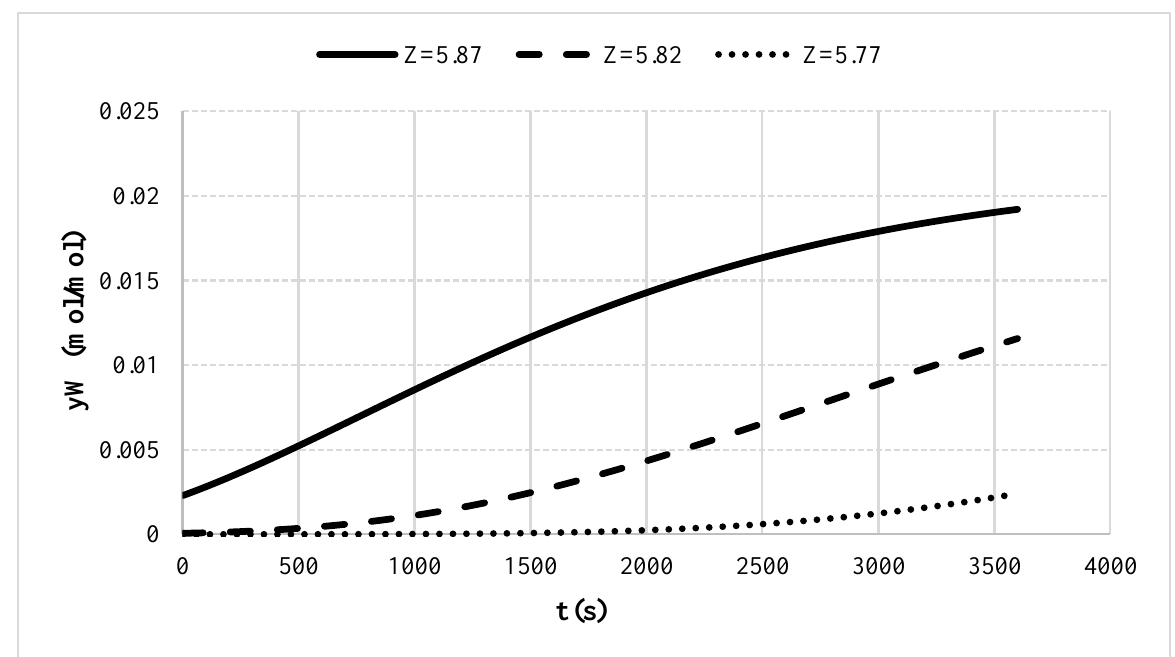
12 of 25 Figure 6. Water mole fraction in the output stream in natural gas with time.